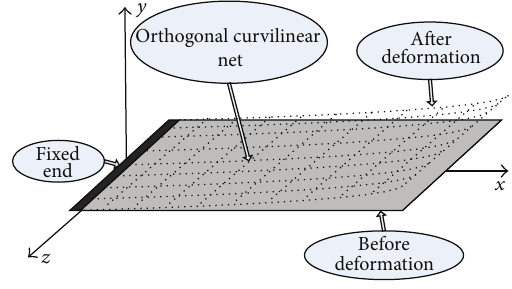
Figure 2: Orthogonal curve